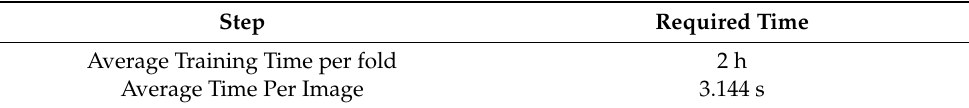
Table 4. Time consumption in our proposed